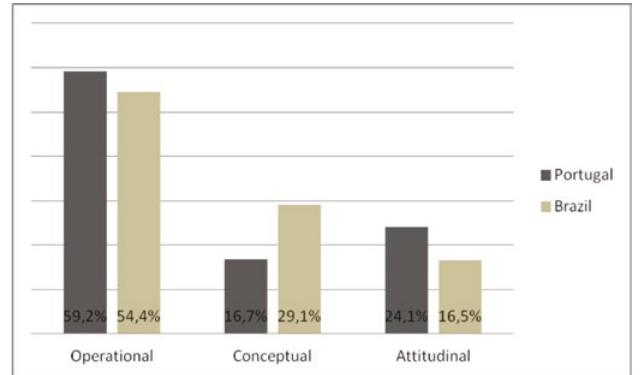
Figure 3: Distribution of category dimensions – Portugal / Brazil.